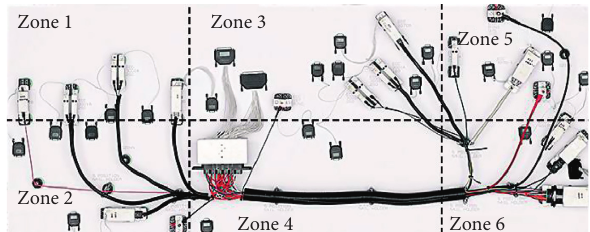
Figure 12: Illustration of the distribution of the fixtures on an assembly table and the definitions of the zones. As the fixtures move according to the assembly tables of the conveyor system, the fix- tures are identically placed at every